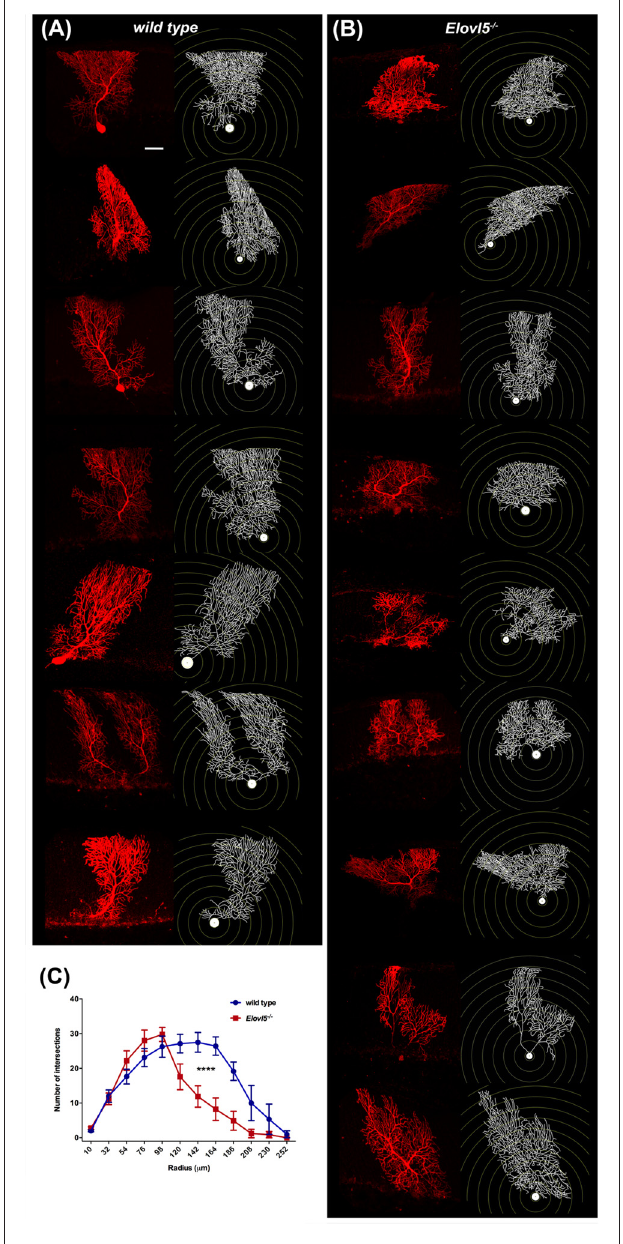
FIGURE 6 | Reduced PC dendritic tree extension in Elovl5 − / − mice. Biocytin filled PCs and reconstructed dendritic structures for wild type (A) and Elovl5 − / − mice (B) . (C) Sholl plot graph showing a smaller number of intersections in the distal part of dendritic tree for Elovl5 − / − PCs, indicating a reduced extension the dendrites (cells: n = 9) relative to their wild type littermates (cells: n = 8; ∗∗∗∗ p < 0.001, two-way ANOVA). Scale bar 40 µ m.